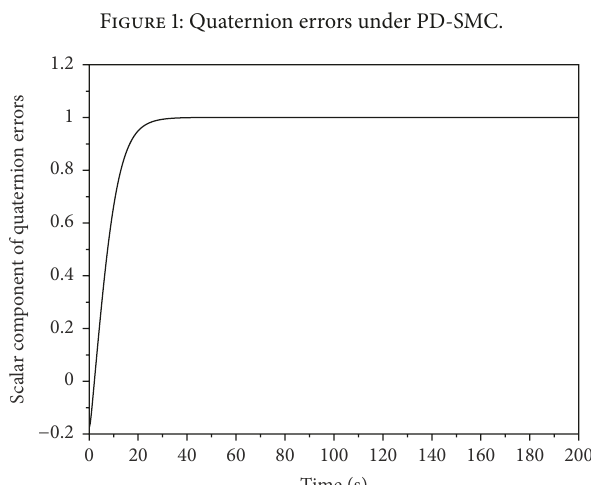
Figure 4: Sliding surface under PD-SMC.